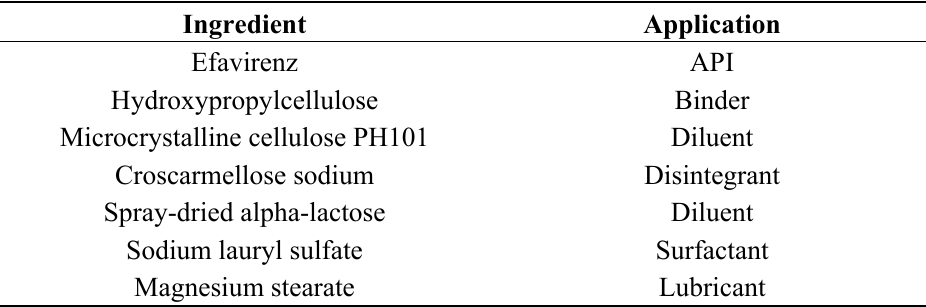
Table 1 . Formulation of efavirenz